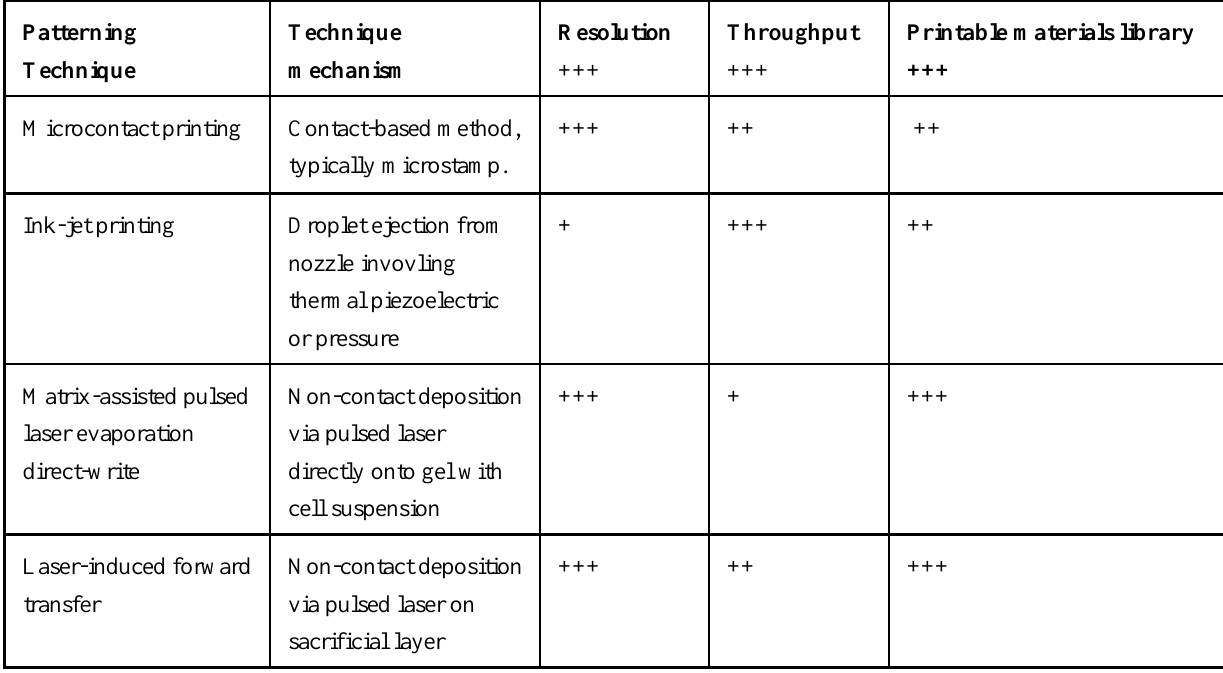
Table 2. Selected patterning biofabrication methods, performance, and some materials that have been